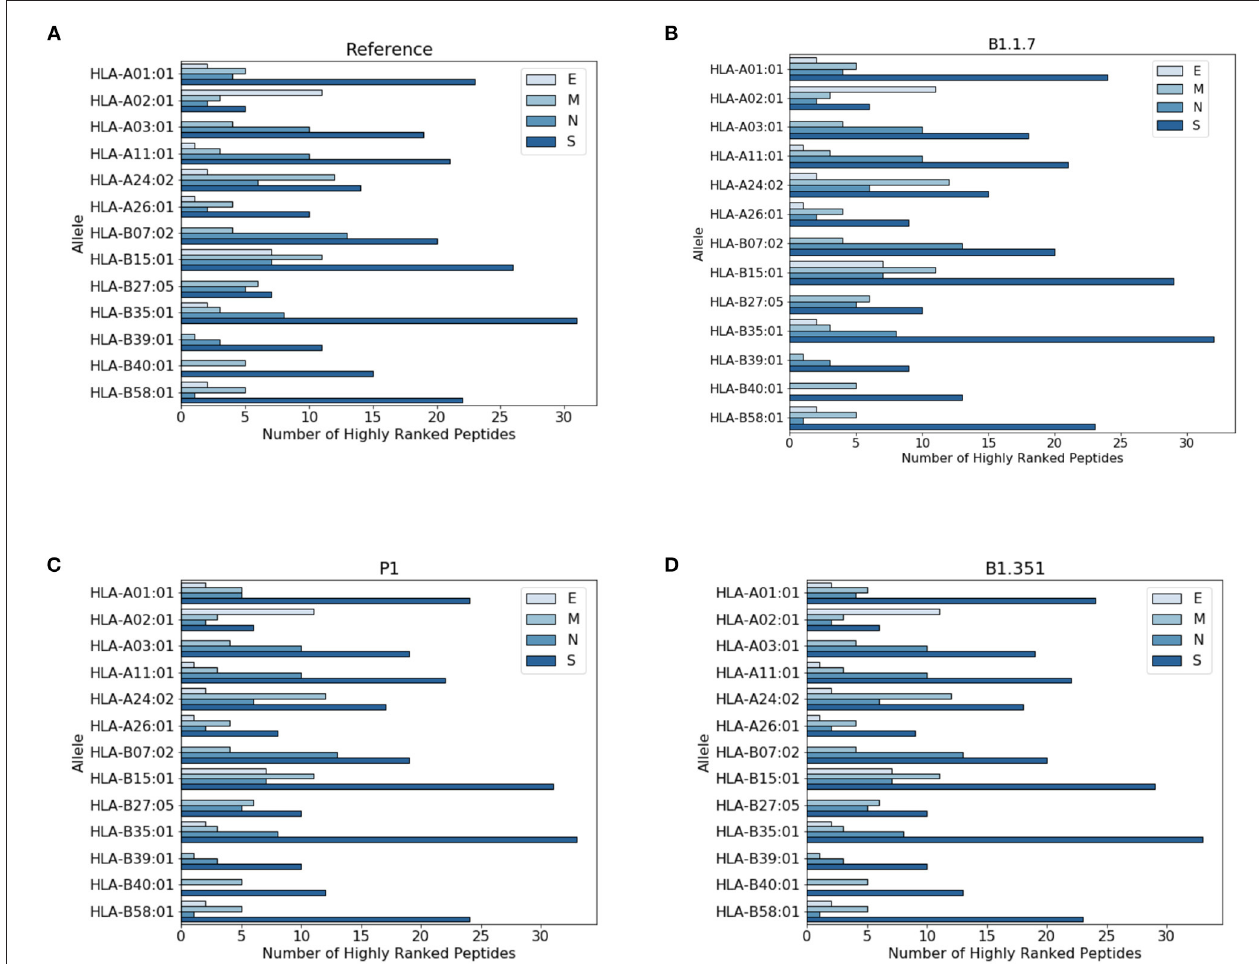
FIGURE 3 | Distribution of highly ranked peptides across viral proteins. (A) Reference virus, (B) B1.1.7 (C) P1, and (D) B1.351.